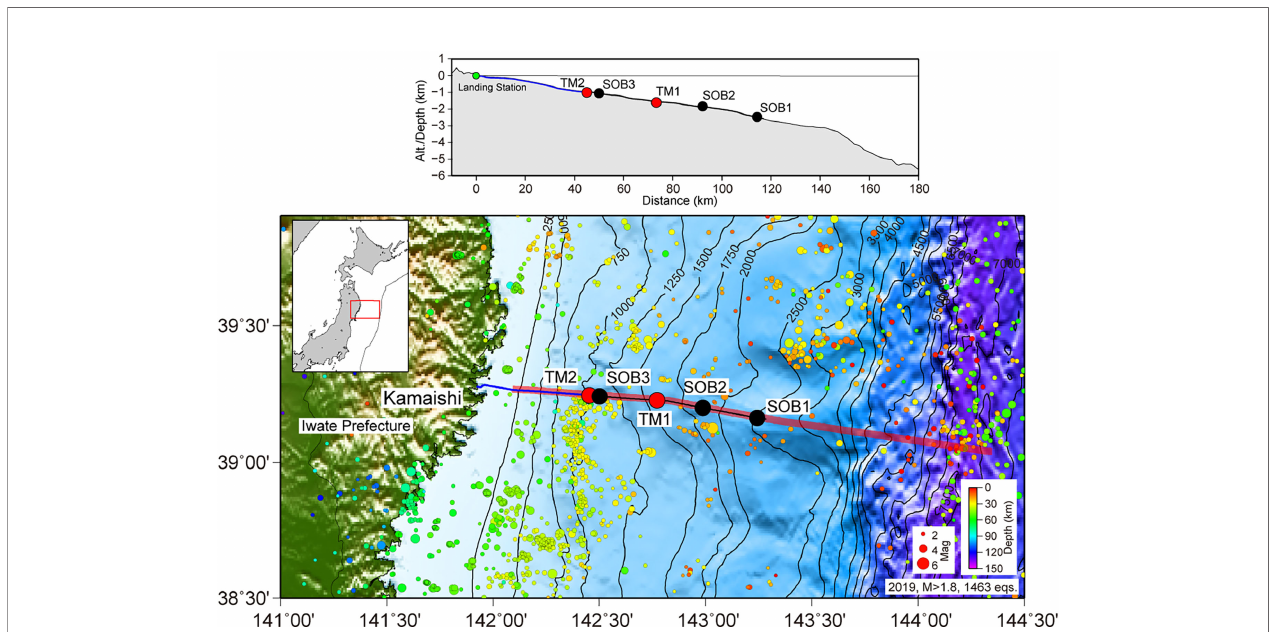
FIGURE 1 | The sea fl oor cable observation system off Sanriku installed in 1996. Upper: depth pro fi le of the cable system. The sea fl oor gradually deepens toward the Japan trench. Lower: the position of the sea fl oor cable. Black and blue lines indicate the cable route of the 1996 system. Blue lines denote a segment where the cable is buried. Black and red circles show the positions of the seismometers and tsunami-meters. Translucent red lines indicate the pro fi le of the seismic survey using an array of large airguns. Colored circles denote epicenters of earthquakes with magnitudes greater than 1.8 occurring in 2019. Size and color of circles indicate magnitude and depth of events,